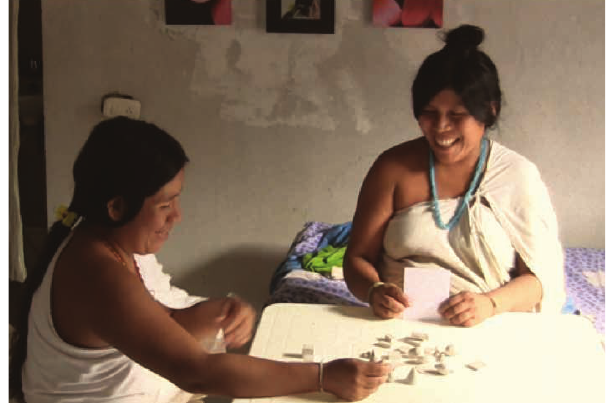
Figure 3: Setup of matching task Two sessions of the task were carried out by a total of four speakers, who switched roles halfway through. The task was recorded on video and